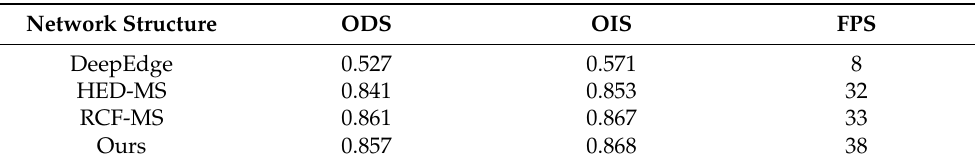
Table 1. Comparison of detection results of different network structures.